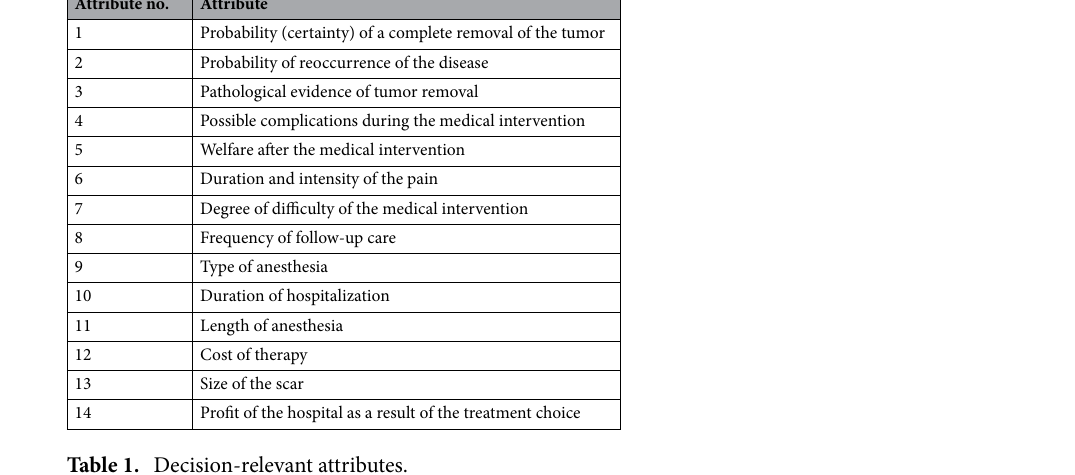
Table 1. Decision-relevant